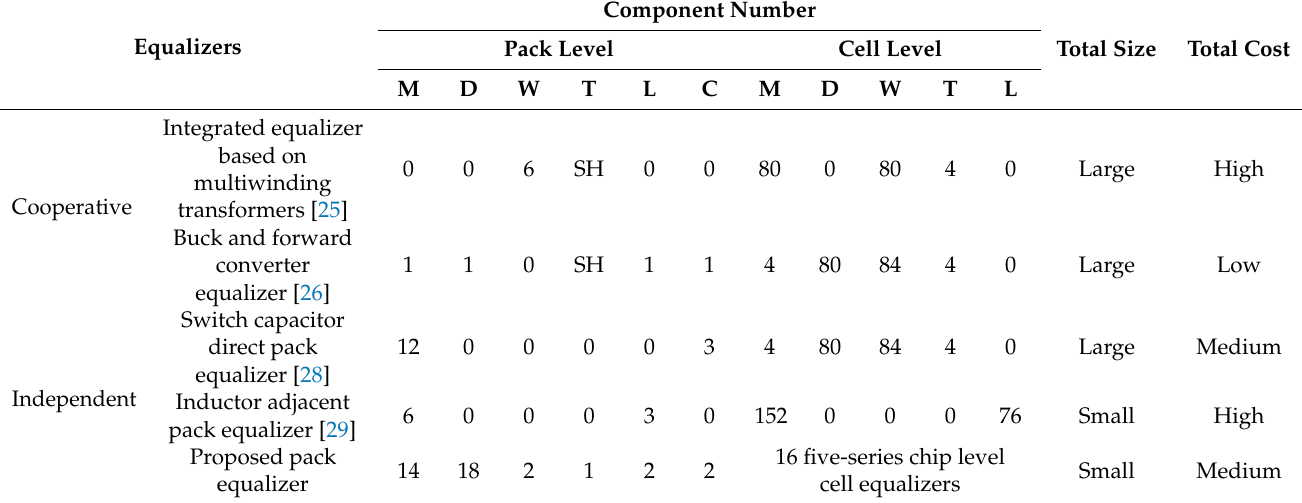
Table 9. Comparison of the pack equalizers with their supporting cell equalizers in terms of component number, total size and